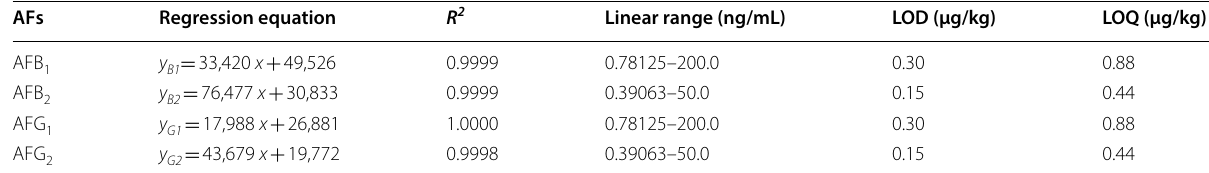
Table 1 Regression equation, LOD and LOQ of four aflatoxins AFs Regression equation